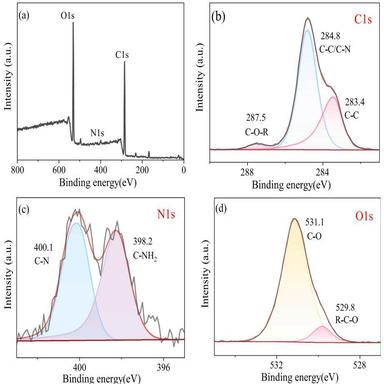
(a) Full scale XPS spectrum of CO2-responsive phase transfer materials (PEG-200); (b) C1s XPS spectrum; (c) N1s XPS spectrum; (d) O1s XPS spectrum.